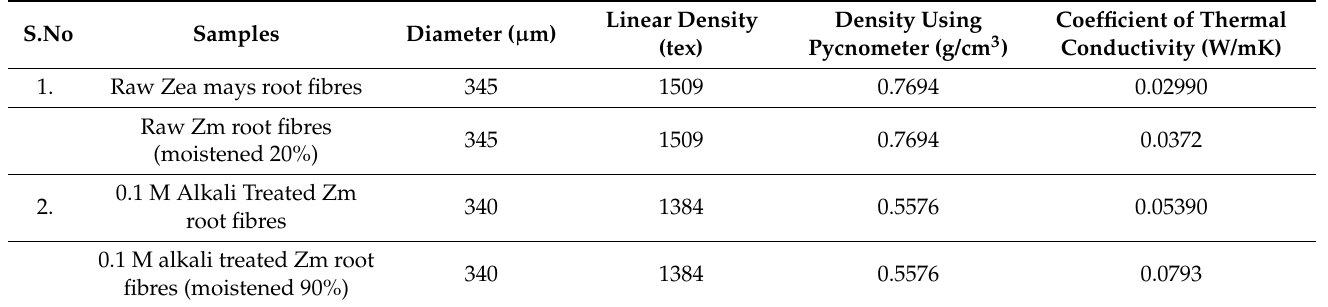
Table 1. Physical properties of Zm